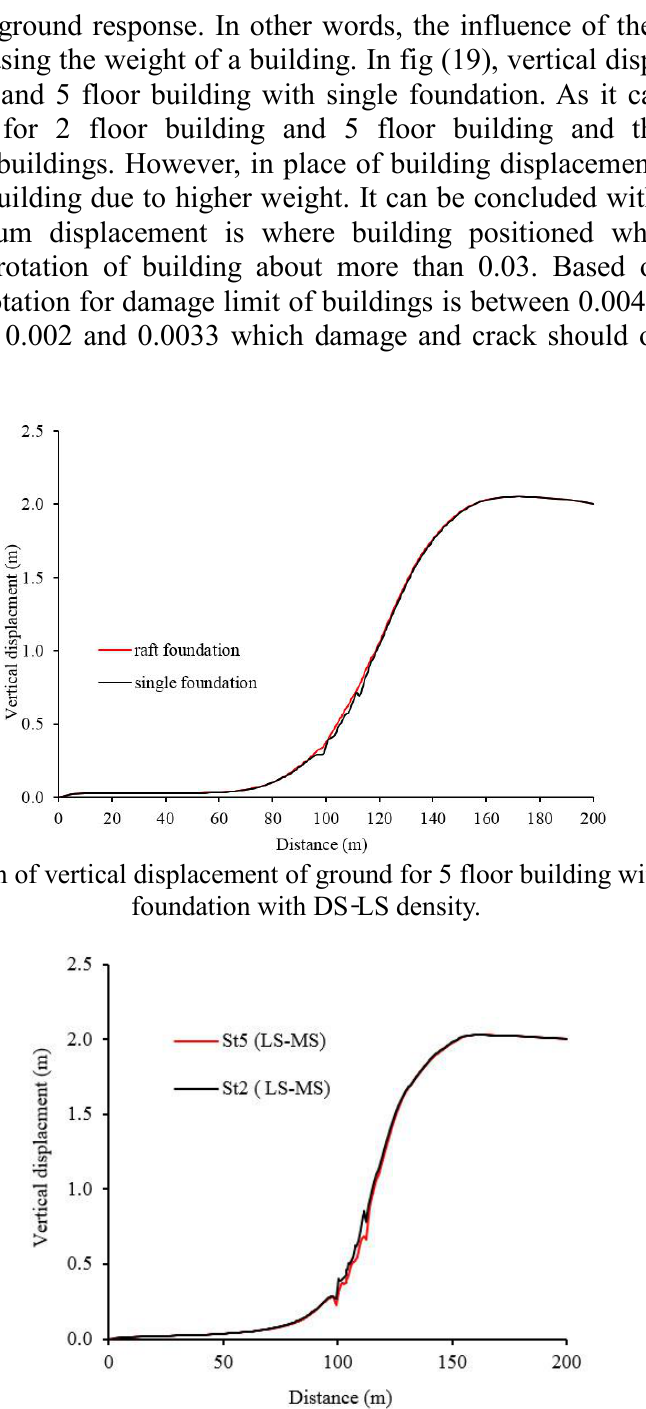
Fig. 19. Comparison of vertical displacement of ground for 2 and 5 floor buildings with single